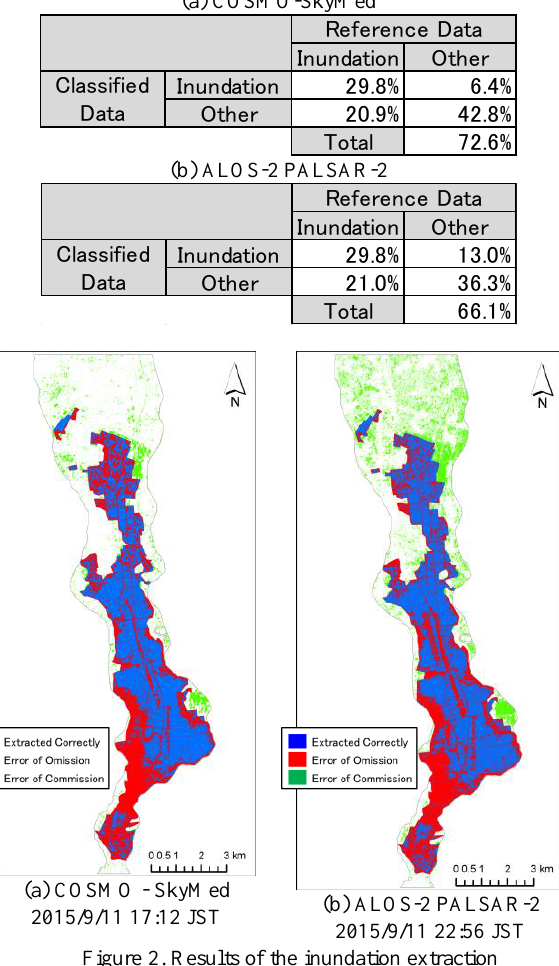
Table 4. Results of accuracy assessment